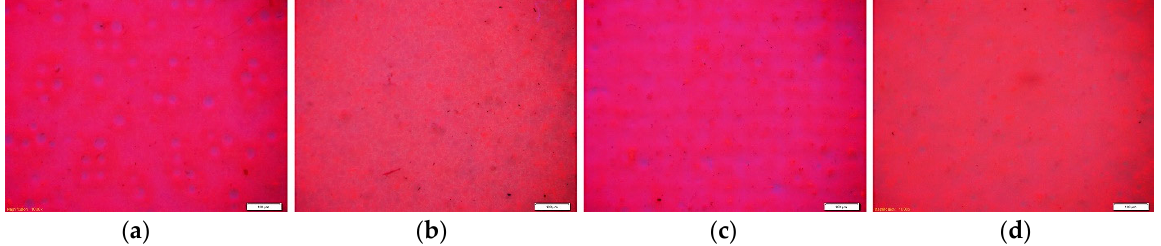
Figure 11. Microscopic images of coatings illuminated by UV light source ( a ) FC + 1% SiO 2 —unaged sample; ( b ) FC + 1% SiO 2 —aged for 12 h; ( c ) FC + 3% SiO 2 —unaged sample; ( d ) FC + 3% SiO 2 —aged for 12 h.